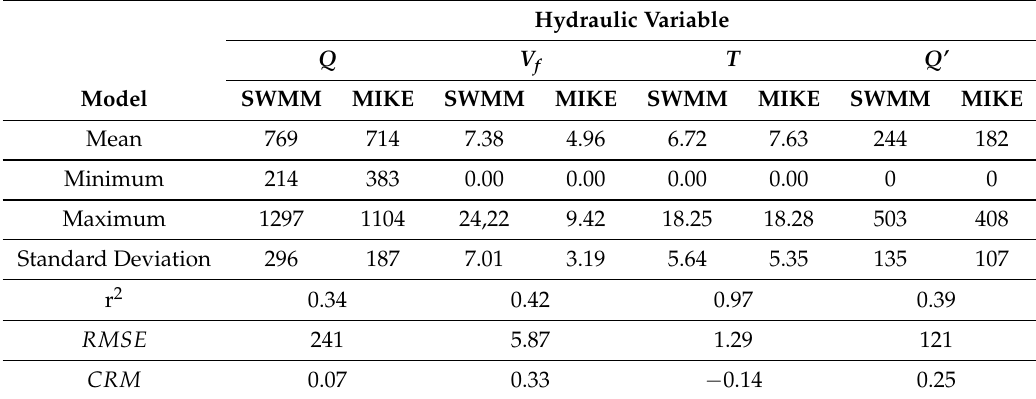
Figure 9. Plot of the 17 rainfall-runoff events simulated by SWMM and MIKE models in the Corace torrent (Calabria, Southern Italy). Table 6. Values of the criteria adopted for comparing the hydraulic variables simulated by SWMM and MIKE models in the Corace torrent (Calabria, Southern